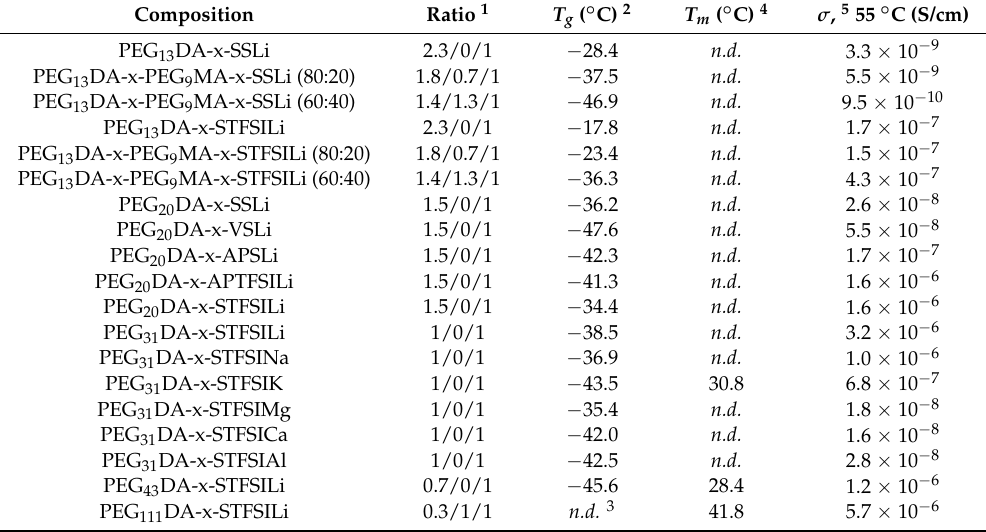
Table A1. Monomer ratios, thermal transition data, and DC ionic conductivity for crosslinked electrolytes of select